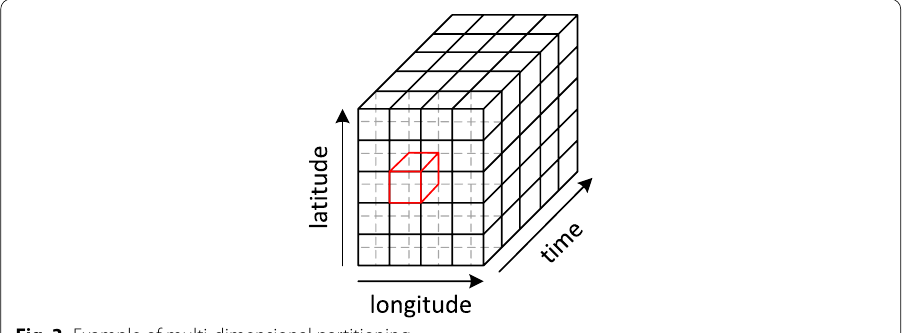
Fig. 3 Example of multi-dimensional partitioning